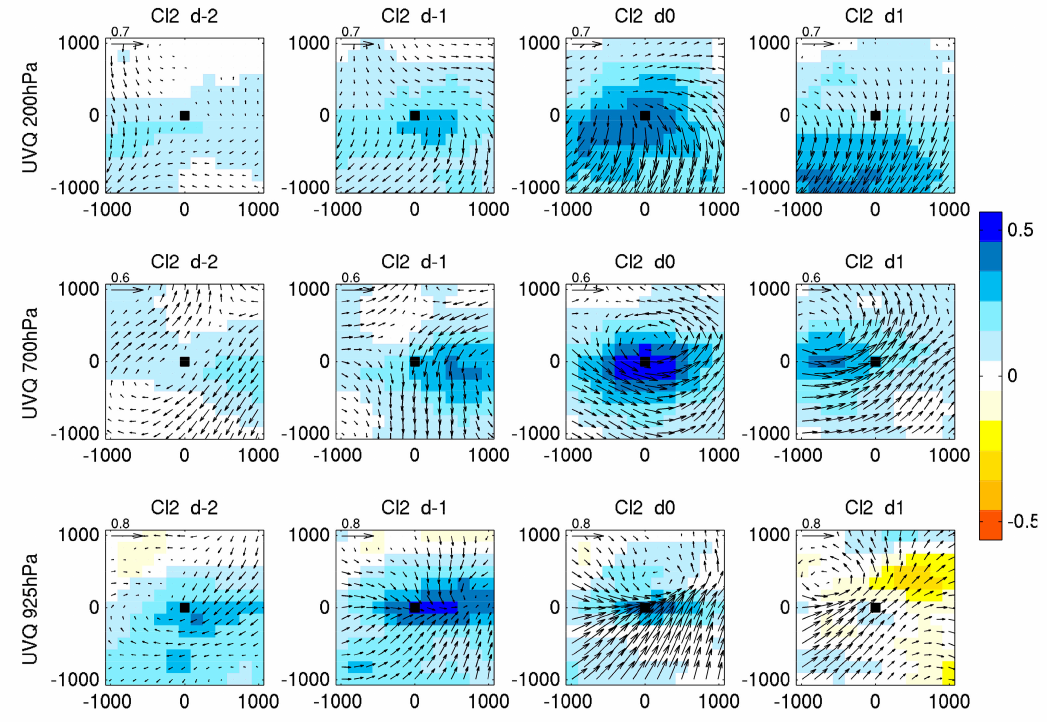
Figure 12. Same as Figure 11 but for cluster